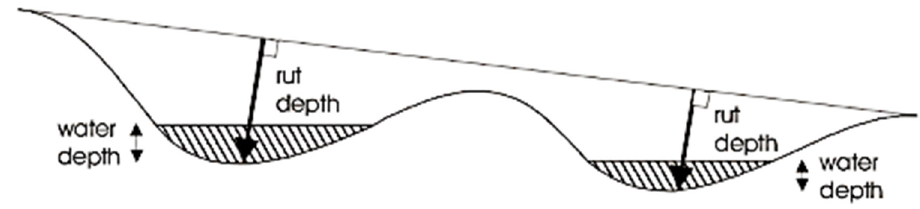
Figure 2. Accumulation of rainfall water in a pair of ruts [18].